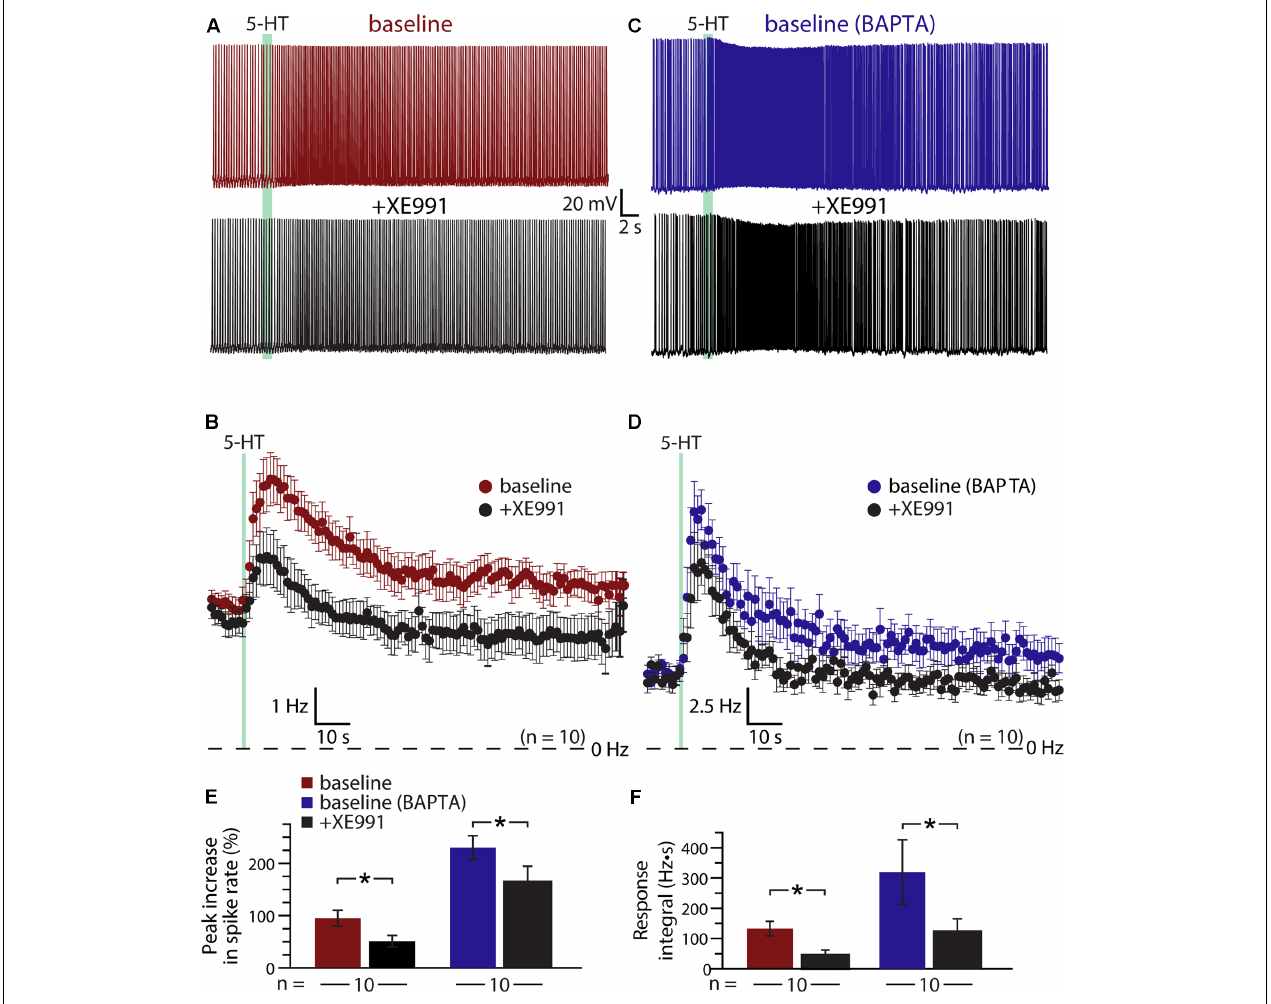
FIGURE 6 | Suppression of K V 7 channels contributes to serotonergic excitation of COM neurons. (A,C) Responses to 5-HT (green bars) in a control COM neuron (red, A ) and a COM neuron patched with 10 mM BAPTA (blue, C ) in baseline conditions and after blockade of K V 7 channels with 10 µ M XE991 (black). (B , D) Plots of mean instantaneous spike frequencies for 10 control (B) and 10 BAPTA-filled (D) COM neurons in baseline (red or blue) and XE991 (black) conditions. (E , F) Comparisons of peak increases in instantaneous spike frequencies (E) and response integrals (F) in baseline conditions (red or blue) and after addition of XE991 (black) for control and BAPTA-filled COM neurons,